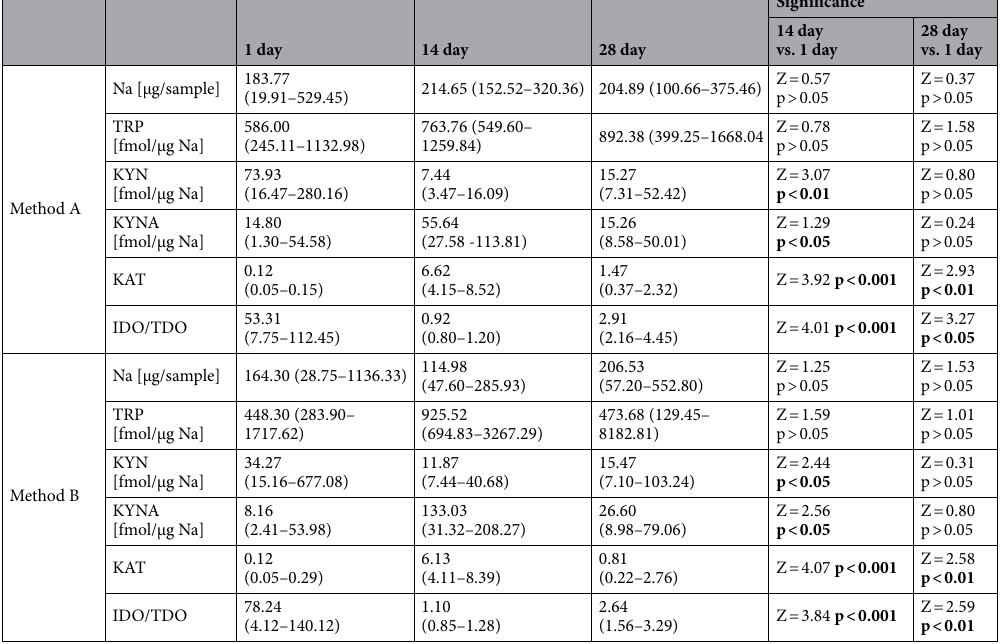
Table 1. Content of natrium (Na), tryptophan (TRP), kynurenine (KYN) and kynurenic acid (KYNA), and activity of indoleamine-2,3-dioxygenase and tryptophan-2,3-dioxygenase (IDO&TDO) and kynurenine aminotransferase (KAT) in human sweat during physical training: upper panel—sampling method A; lower panel—sampling method B. Data expressed as the median with a range of variation (25–75%) are presented as the content of determined substance in fmol per µg of Na.